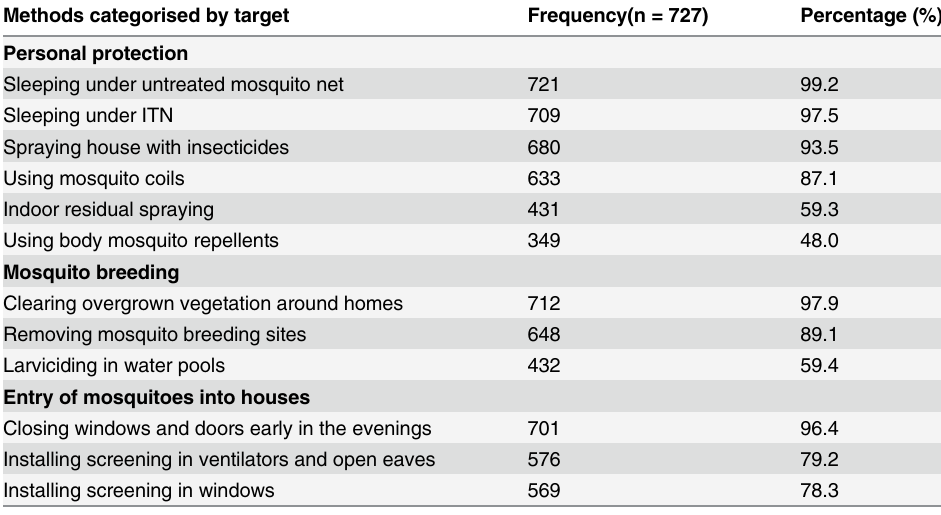
Table 2. Awareness of malaria prevention methods in the integrated approach. Methods categorised by